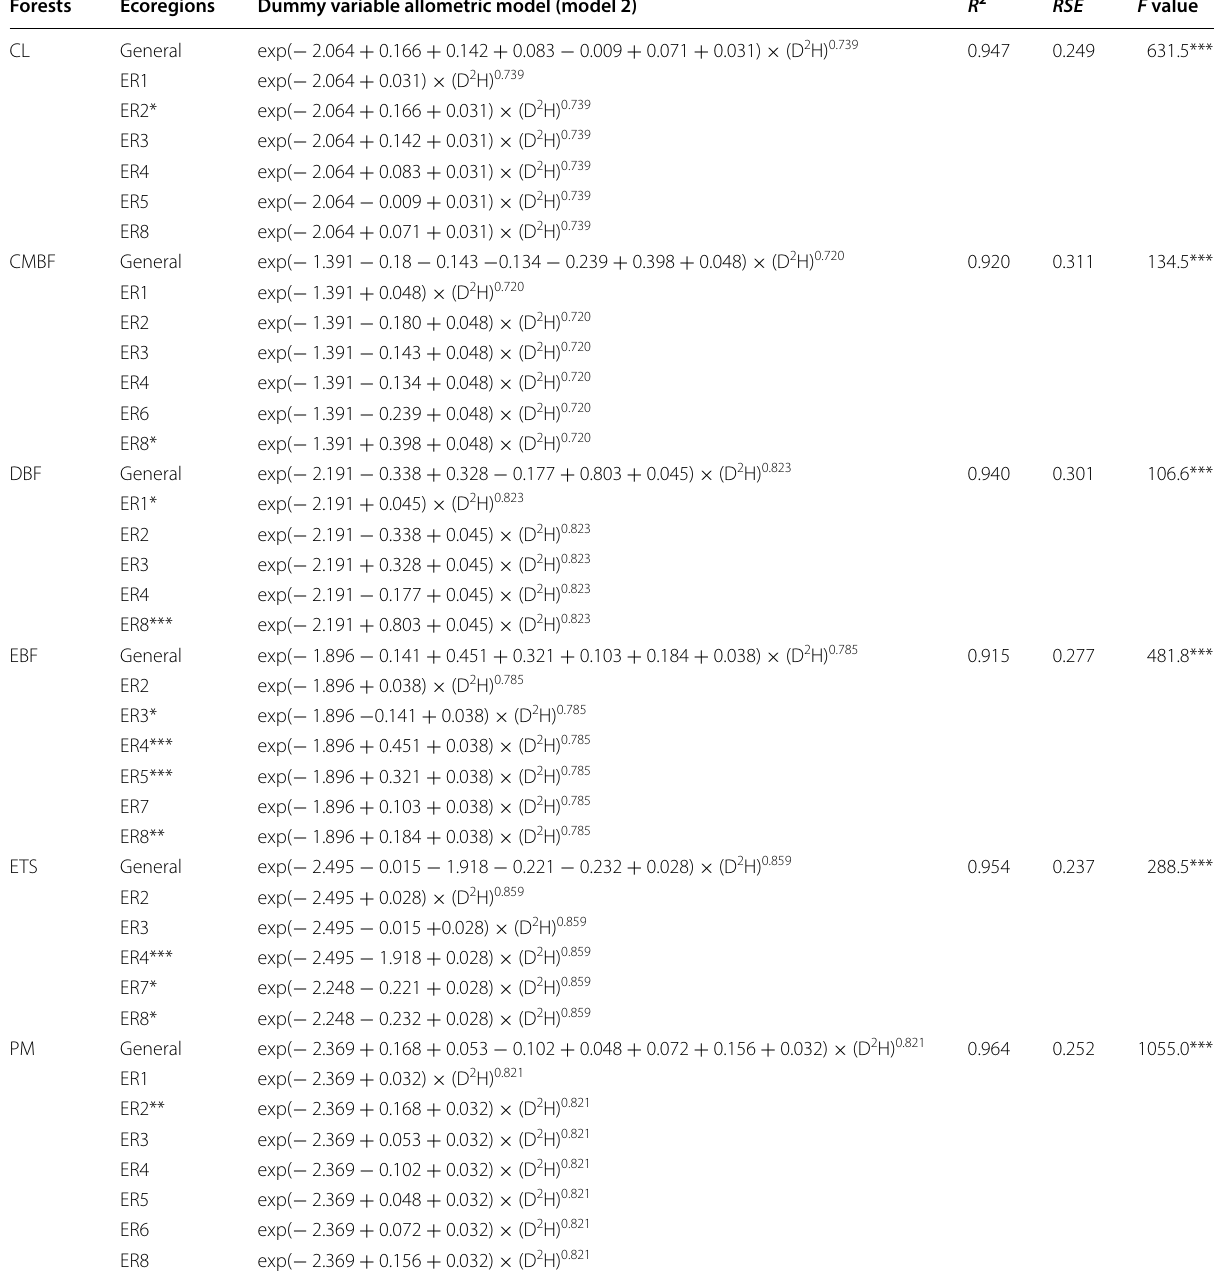
*** Indicates significant at p < 0.001 level; ** indicates significant at p < 0.01 level; * indicates significant at p < 0.05 level. See Table 1 for the abbreviations of the forest types and ecoregions